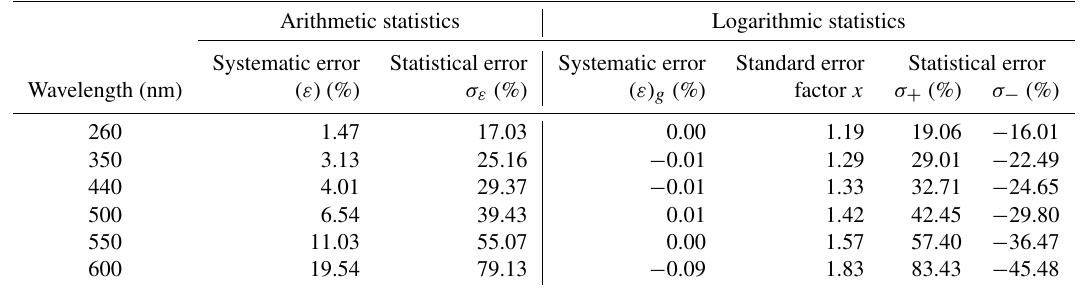
Table 3. Relative errors of the empirical model given by Eq. (13) for determining spectral values of CDOM absorption coefficients ( a CDOM (λ)) at selected wavelengths.